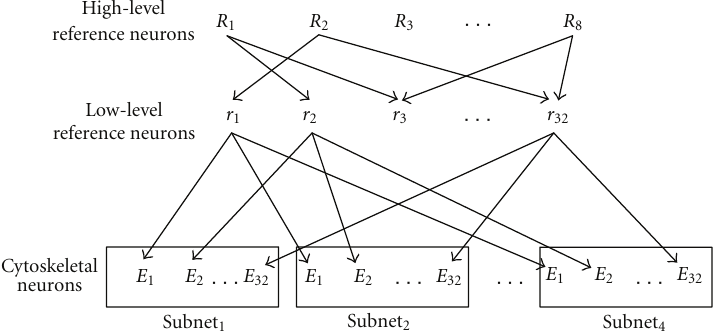
Figure 7: Hierarchical inter-neuronal control architecture.